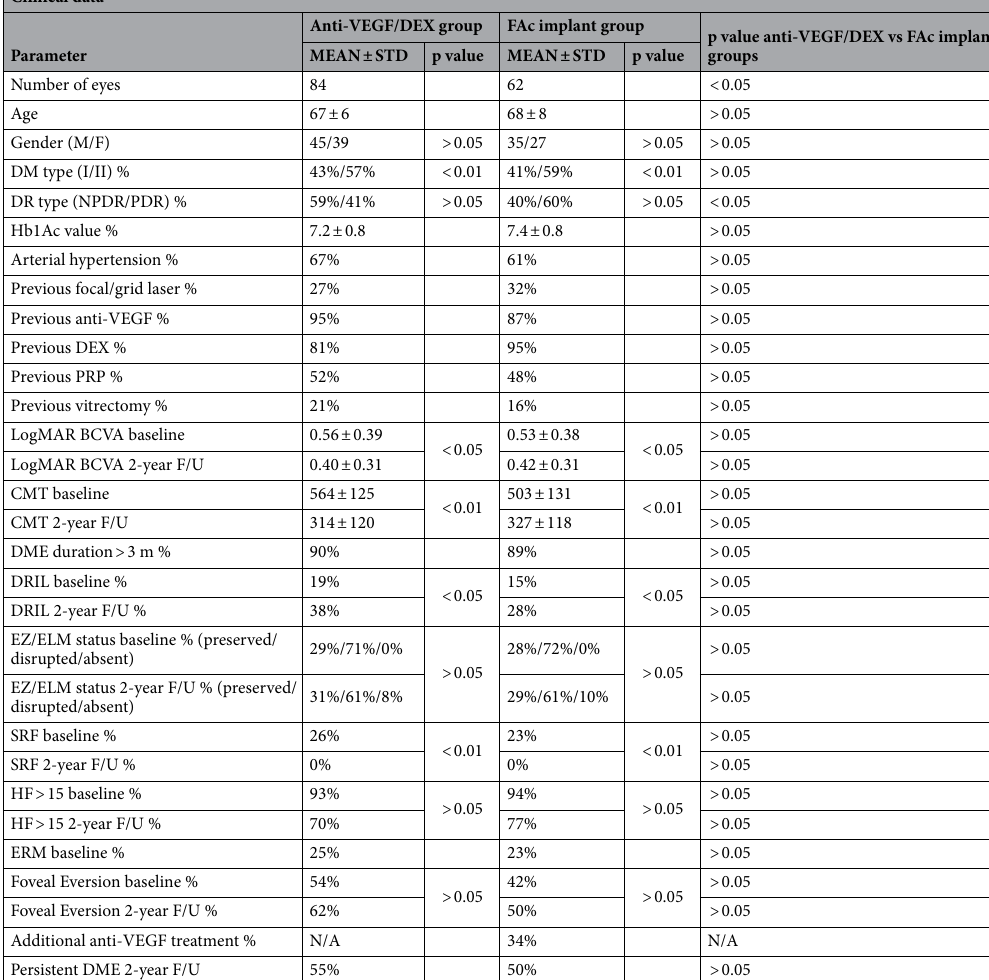
Table 1. Clinical data in anti-VEGF/DEX and FAc-treated DME eyes. DR diabetic retinopathy; DME diabetic macular edema, PRP panretinal photocoagulation, DEX dexamethasone, BCVA best corrected visual